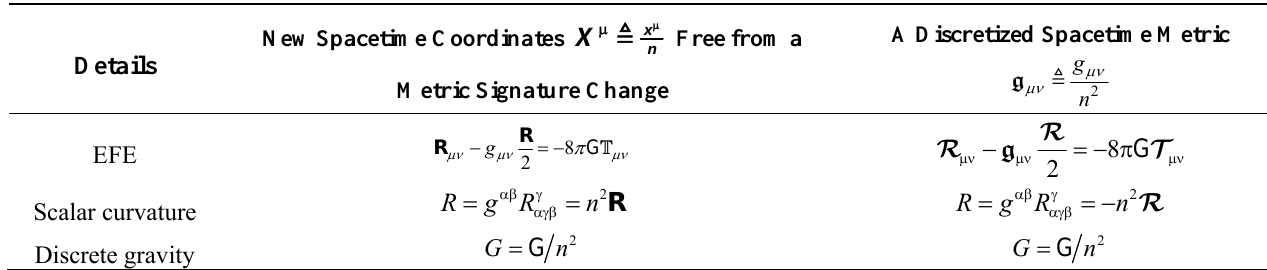
Table 3. Main differences between the two independent discrete solutions obtained for ξ = ±2 π .